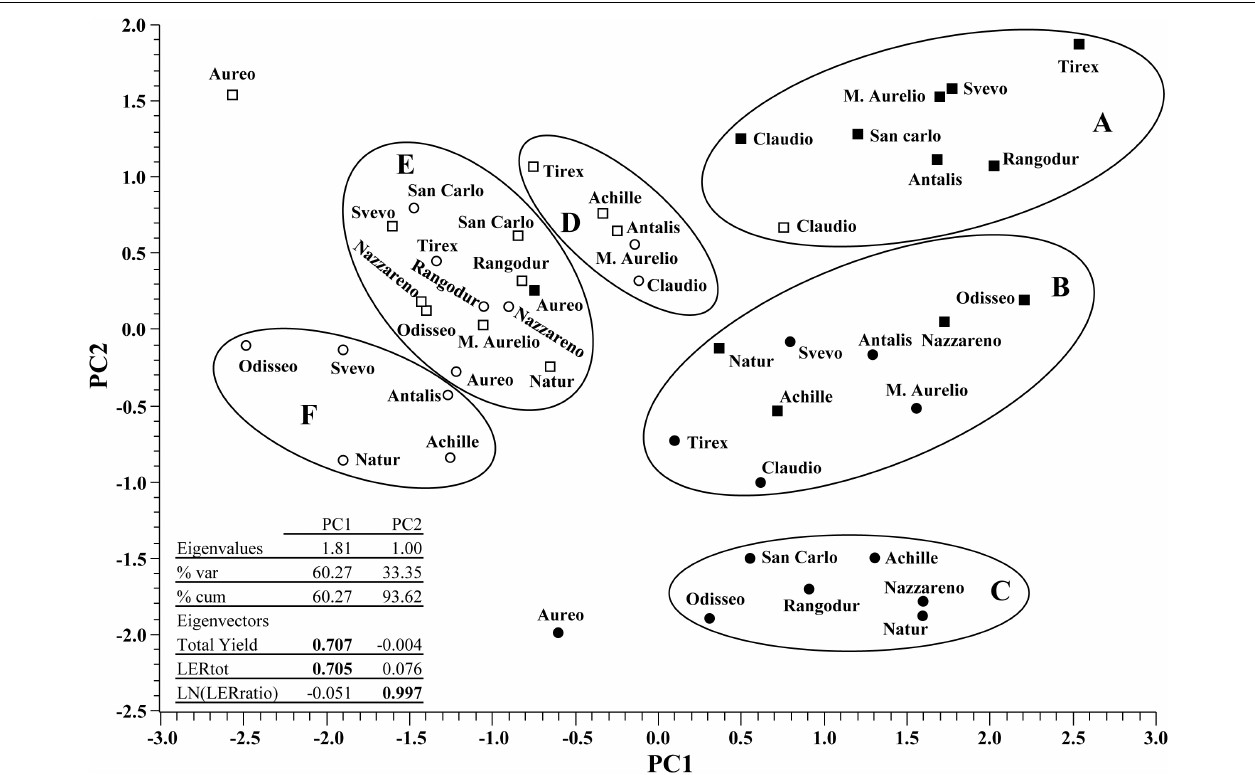
FIGURE 2 | Scatterplot of principal component analysis (PCA). Circles and squares represent mixed crop combinations with Chiaro di Torrelama and Prothabat69, respectively. Mixed crops grown in 2019 and 2020 are indicated in black and white, respectively. Capital letters (A–F) indicate groups identified in cluster analysis (as shown in Supplementary Figure 2